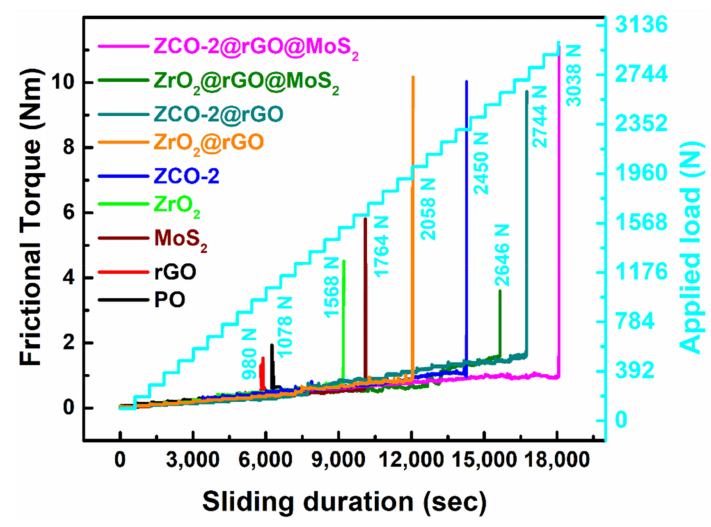
Figure 8. Variation of frictional torque as a function of stepwise loading and time for PO in absence and presence of di ff erent nano additives: Sliding speed, 600 rpm; temperature, 75 ◦ C; concentration of additives, 0.125% w /